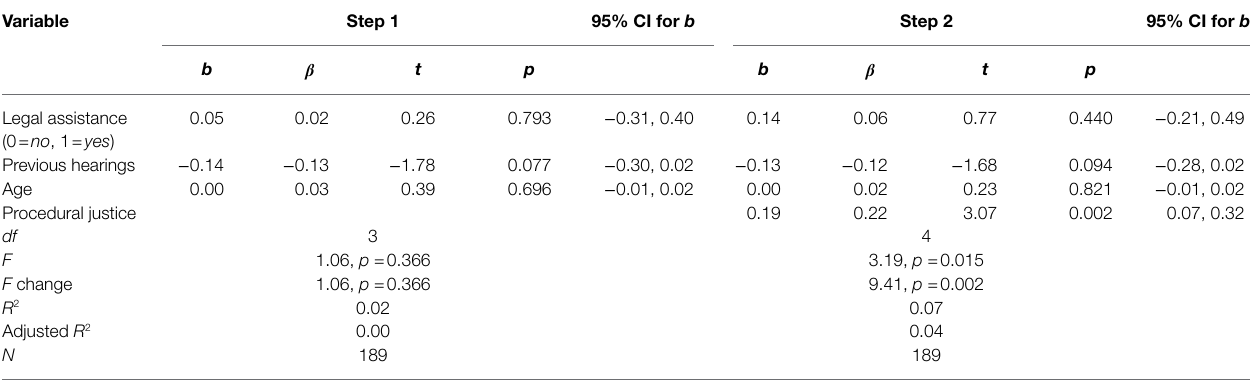
TABLE 6 | Self-esteem regressed on procedural justice and relevant background variables. Variable Step 1 95% CI for b Step 2 95% CI for